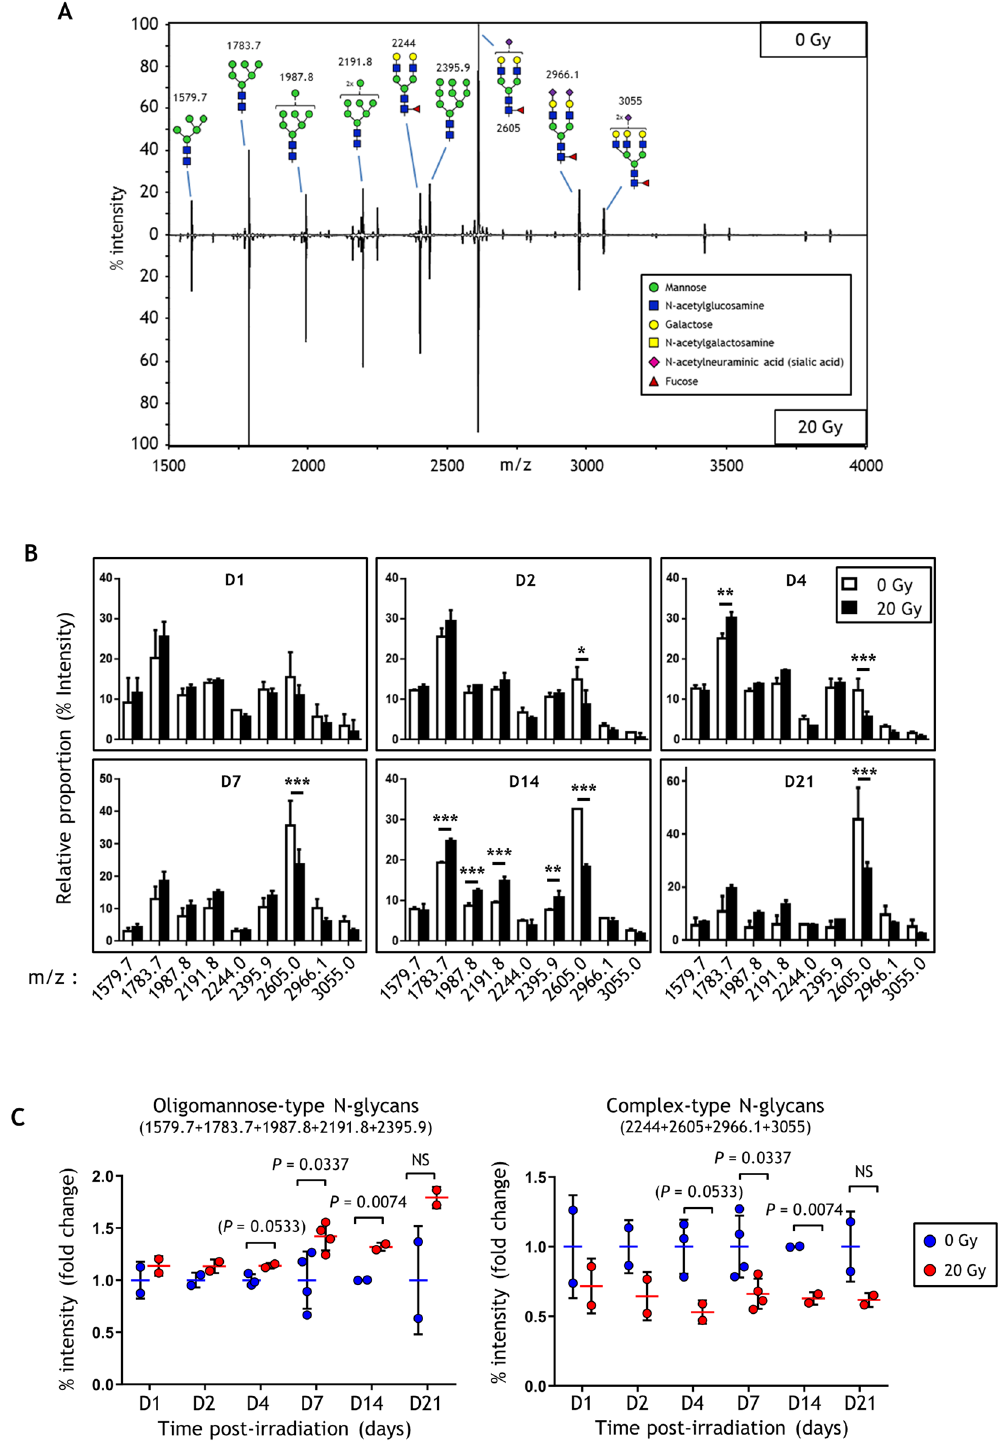
Figure 2. Quantification of N-glycan structures of HUVECs by MALDI-TOF mass spectrometry. ( A ) Representative MALDI-TOF MS mirror spectra of permethylated N - glycans derived from control and 20 Gy- irradiated HUVECs 14 days post-exposure. ( B ) Changes in relative abundances of the nine structure species observed in glycosylation patterns between control and 20 Gy-irradiated HUVECs (mean + / − SD). Data were analyzed by two-way ANOVA. * p < 0.05; ** p < 0.01; *** p < 0.001. ( C ) Changes in relative abundances of oligomannose- and complex-type N-glycans observed in glycosylation patterns between control and 20 Gy- irradiated HUVECs (mean + / − SD). Data analyzed by two-tailed t -test. The experiment was replicated twice (two different cultures) with n = 2 repeated measures and n = 3 spectrum acquisitions within each replication for D7, and twice (two different cultures) with n = 1 repeated measures and n = 3 spectrum acquisitions within each replication for the other time points. Data represent the mean of the two